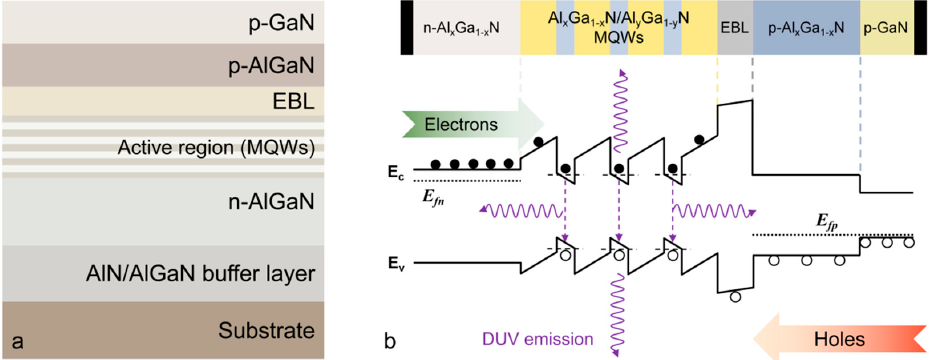
Figure 3. Schematic diagram for ( a ) epitaxial structure and ( b ) energy band structure of a typical AlGaN-based UV LED, which are suitable for sub-250 nm LEDs, too.